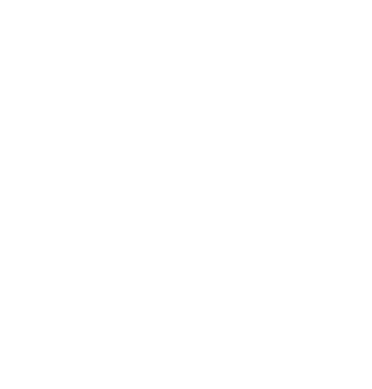
Figure 1. Schematic highlighting a typical clockwise strain gauge with defined coordinate system. In case of the incremental HDM, by incrementally removing the stressed material the surface deformations are measured at a sequence of steps using the strain gauges. From data obtained, the in-depth non-uniform profiles of residual stress are derived. For such purpose, Equation (1) can be developed with the incremental integral formalism.